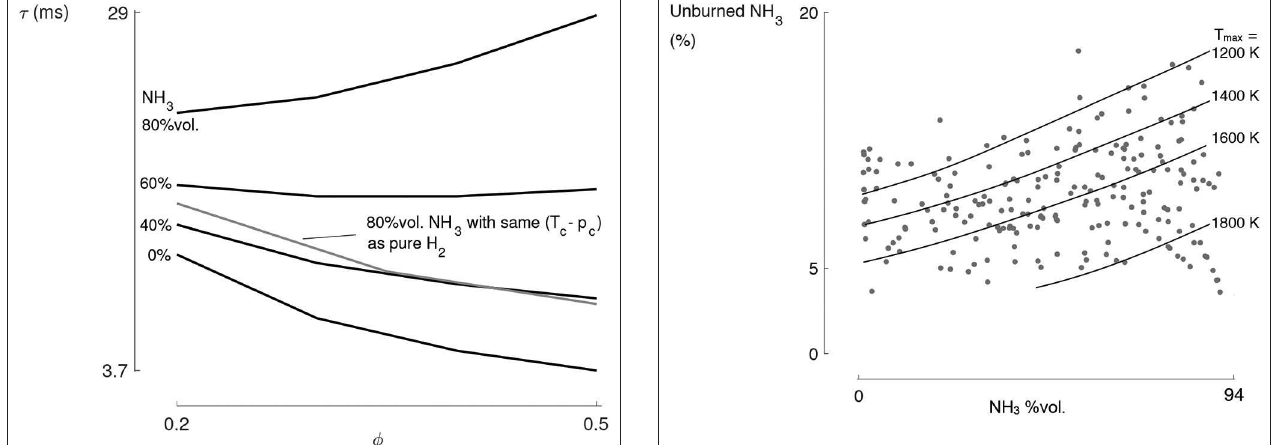
FIGURE 16 | The ammonia unburned fraction is correlated to the ammonia fuel fraction and the maximal combustion temperature (T max ) iso-lines (all the experiments). It does not go below 5% because of the piston